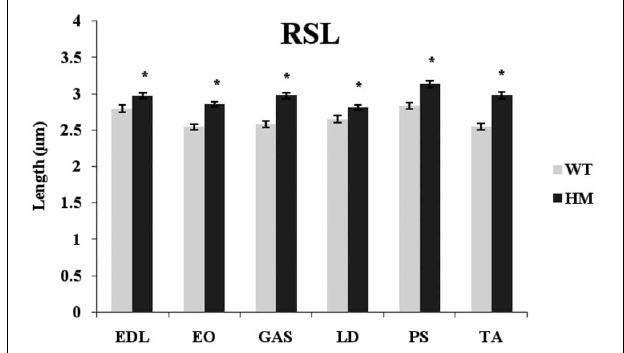
FIGURE 6 | Rest sarcomere length (RSL) in different muscles and rat genotypes. See Figure 3 for muscle and genotype abbreviations. ∗ P < 0 .